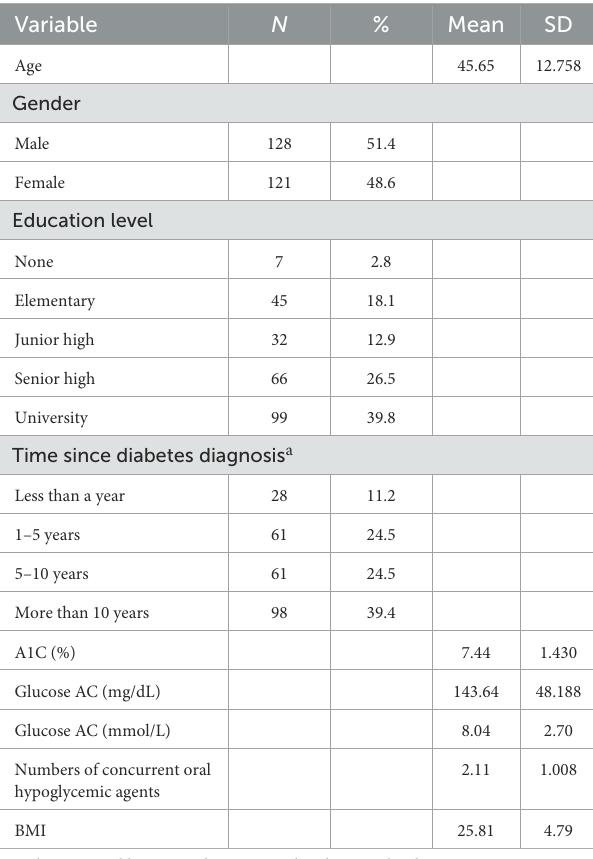
TABLE 1 Descriptive information of respondents’ demographics ( N =